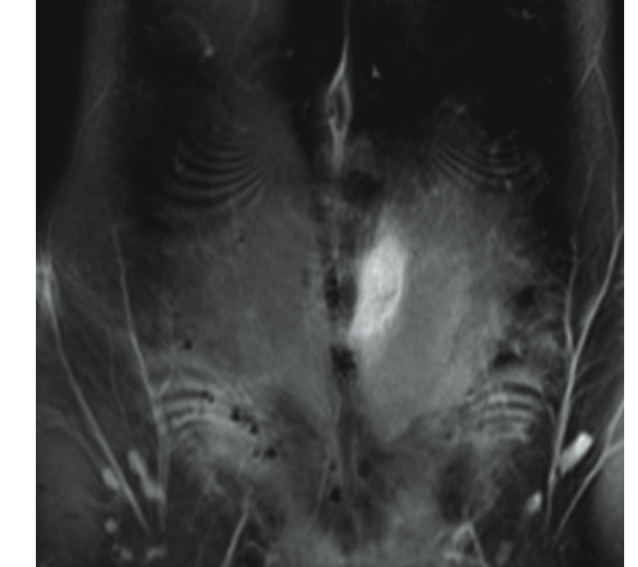
Fig. 4. Coronal post-Gd T1-weighted